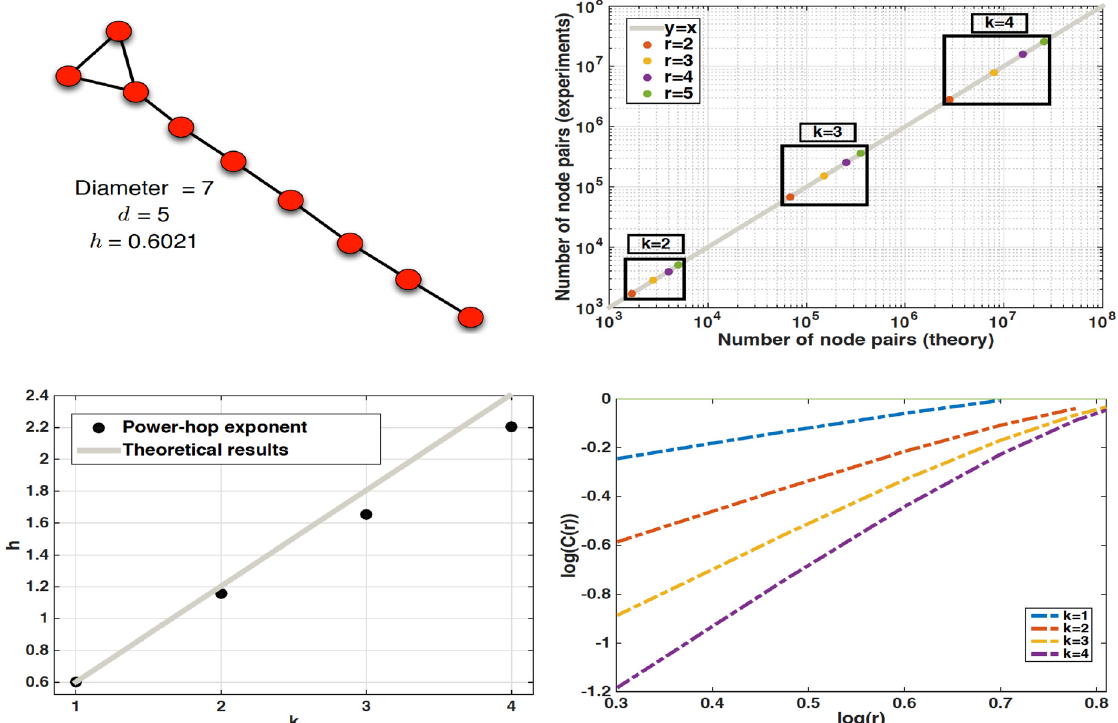
Fig 5. Numerical demonstration of Lemma 1. Using a seed network with large enough diameter to obtain statistically meaningful results (top left figure), we validate Lemma 1. As we can see at the top right figure the number of pair of nodes within distance r expected from Lemma 1 is equal to the one computed from the networks. Furthermore, the computed power-hop exponent is very close to the one expected from our lemma as well (bottom left figure). Finally, the actual scaling behavior for the networks after each Kronecker iteration are presented at the bottom right figure.